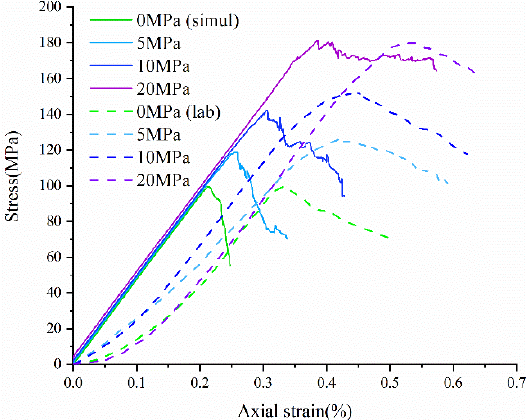
Figure 8. Comparison of numerical simulation and experimental stress–strain curves under different